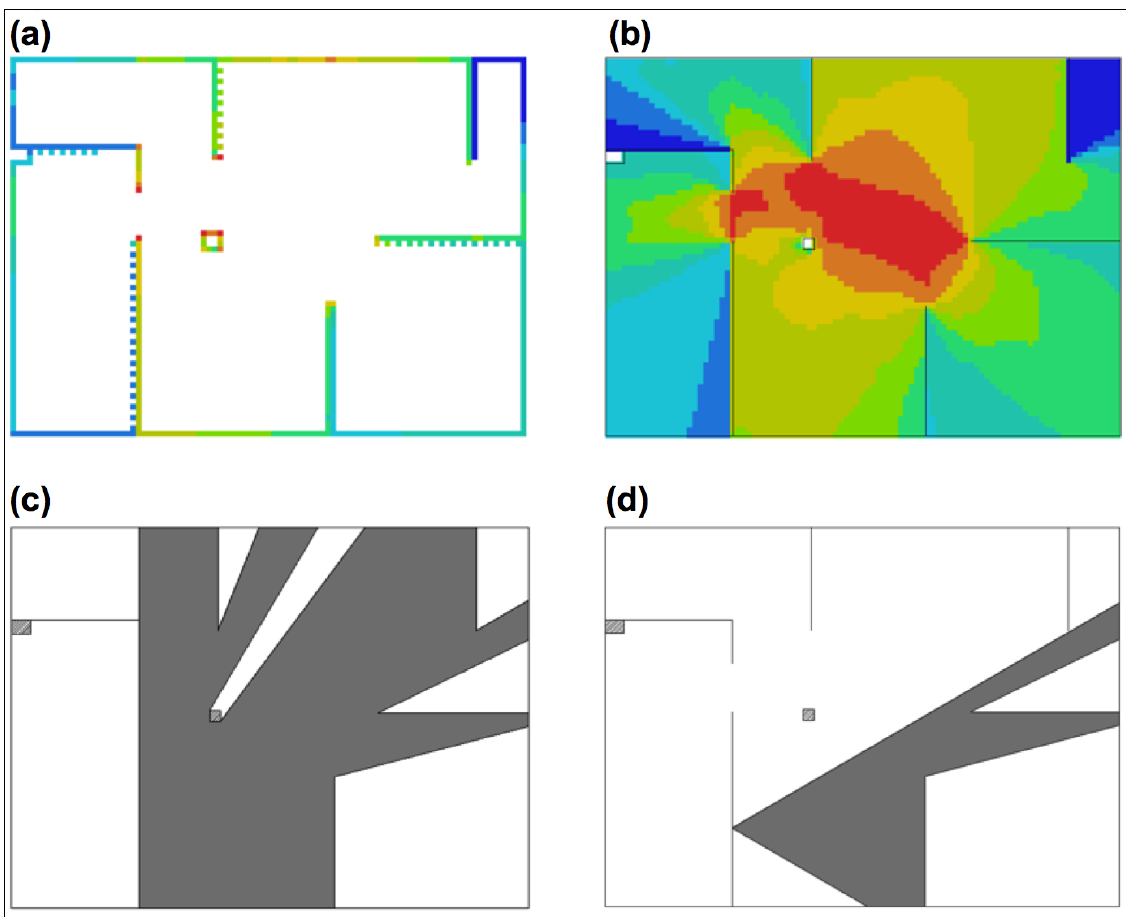
Figure 3. Some spatial analyses used in the study: (a) Boundary Visibility Graph